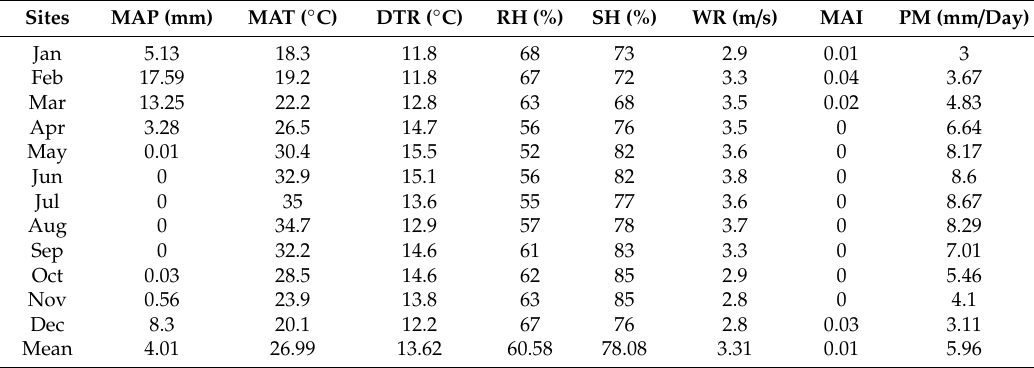
MAP, mean annual precipitation; MAT, mean annual temperature; DTR, daily temperature range; RH, relative humidity; SH, sunshine hours; WR, wind run; MAI, moisture availability index; and PM, Penman-Montieth.